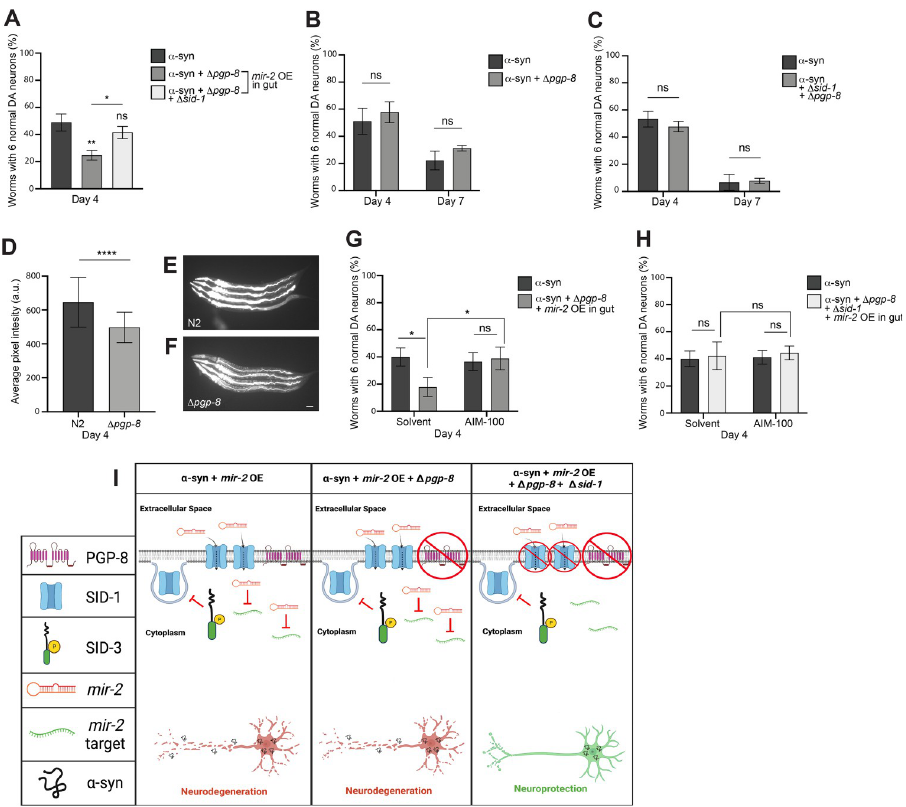
Fig 7. Loss of both SID-1 and PGP-8 functionality reduces mir-2 OE-induced enhancement of neurodegeneration. ( A ) DA neurons were scored for neurodegeneration at day 4 post-hatching in an α -syn model background with mir-2 OE in the intestine (P ges-1 :: mir-2 ), with a Δ pgp-8(ok2489) mutant and Δ pgp-8(ok2489); Δ sid-1(pk3321) double mutant. Values represent mean + S.D. (n = 30 worms per genotype/group per replicate, 3 replicates of 3 independent stable lines). One-Way ANOVA with Tukey’s post hoc analysis was used to compare all conditions to each other. Symbols above bars are in comparison to α -syn only controls while the straight line is a comparison of the bars indicated; ns P � 0.05, � P < 0.05, �� P < 0.01. ( B , C ) α -syn control worms with pgp-8(ok2489) ( B ) or pgp-8(ok2489); sid-1(pk3321) ( C ) were analyzed for DA neurodegeneration at days 4 and 7 post-hatching. Values represent mean + S.D. (n = 30 worms per genotype per replicate, 3 independent replicates). Two-Way ANOVA with Sˇı´da´k’s post hoc analysis was used to compare α -syn alone with the mutant displayed in the same graph; ns P � 0.05. ( D - F )N2 wildtype and pgp-8 (ok2489) mutant worms following a 48-hour exposure to 10 μ M of rhodamine 123. ( D ) Average pixel intensity was measured 48 hours post-hatching. Values represent mean + S.D. (n = 30 worms per genotype per replicate, 3 independent replicates). Unpaired, two-tailed Student’s t -test was used to compare N2 to pgp-8(ok2489) ; ���� P < 0.0001. Representative images of N2 ( E ) and pgp-8 mutant ( F ) C . elegans (4 worms per panel, anterior to left) exhibiting fluorescence due to rhodamine 123 treatment. Scale bar, 50 μ m. ( G, H ) DA neurodegeneration at day 4 post-hatching. Values represent mean + S.D. (n = 30 worms per genotype/group per replicate, 3 independent replicates of 1 independent stable line). α -syn control worms or the α -syn with mir-2 OE in the intestine (P :: mir-2 ) with pgp- ges-1 8(ok2489) ( G ) or pgp-8(ok2489); sid-1(pk3321) ( H ) were either exposed to the 0.1% ethanol solvent control or AIM- 100 (100 μ M). Two-way ANOVA with Tukey’s post hoc analysis was used to compare all conditions to each other; ns P � 0.05, � P < 0.05. ( I ) An triptych illustration (created with Biorender.com) reflecting an interpretation of the experimentally observed impact on α -syn-induced DA neurodegeneration caused by intestinal overexpression of mir- 2 in either a pgp-8 knockout mutant or a pgp-8 ; sid-1 double mutant. In the left pane, SID-3 blocks the endocytosis of SID-1 on cell membranes, maintaining ample SID-1 on cell surfaces to transport mir-2 into cells, allowing for mir-2 target gene silencing and leading to enhanced neurodegeneration. The middle pane displays the situation when α -syn is expressed in DA neurons and mir-2 is OE in the intestine, while sid-1 is wildtype and pgp-8 is mutant. In this model, SID-3 blocks the endocytosis of SID-1 on the plasma membrane, resulting in the transport of mir-2 for target gene silencing and the enhanced neurodegeneration observed experimentally. It is presumed that a loss of PGP-8 function does not influence mir-2 import into cells, since SID-1 remains functional. The right pane is a model for when both sid-1 and pgp-8 are mutant in animals expressing α -syn in the DA neurons, with mir-2 being overexpressed in the intestine. Here we hypothesize that mir-2 might not be imported into cells either due to a mutation that renders SID-1 non-functional, or by the enigmatic process by which PGP-8 may influence mir-2 import into cells, also associated with a mutation rendering it non-functional. In either case, less or no mir-2 import into cells results, and instead, leads to an infusion of target gene transcription that contributes to the observed